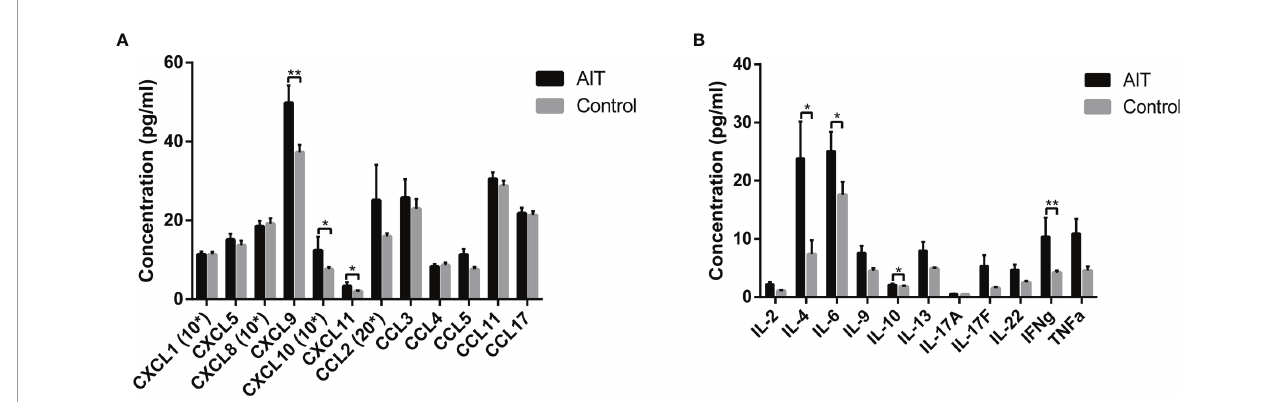
FIGURE 1 | Distribution of cytokines and chemokines in follicle fl uid obtained from patients with and without AIT. Among the 12 chemokines analyzed, concentrations of CXCL9, CXCL10, and CXCL11 were signi fi cantly higher in patients with AIT than those in the control group (A) . Bars represent the mean ± SEM. *P < 0.05 and **P < 0.01 by the Mann-Whitney U test. Among the 11 cytokines analyzed, IL4, IL-6, IL-10, and IFN g concentrations were signi fi cantly higher in patients with AIT than in the control group (B) . Bars represent the mean ± SEM. *P < 0.05 and **P < 0.01 by the Mann-Whitney U test. *10, data needed to be multiplied by 10; *20, data needed to be multiplied by